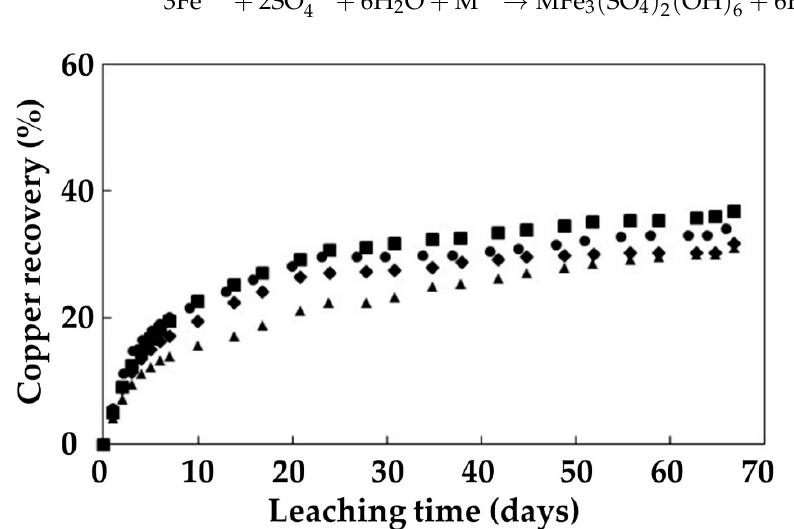
Figure 9. Copper dissolution of chalcopyrite ore with continuous irrigation in 0.5 g/L copper (II) at ambient temperature, with the addition of ▲ 3.0 g/L of acid, 1.0 g/L total iron and 10 7 cells/mL, ■ 3.0 g/L of acid, 1.0 g/L total iron and 5.0 × 10 7 cells/mL, ♦ pH-controlled at 2.0, 1.0 g/L of total iron and 5.0 × 10 7 M cells/mL and ● pH-controlled at 1.5, 1.0 g/L of total iron and 5.0 × 10 7 M cells/mL.